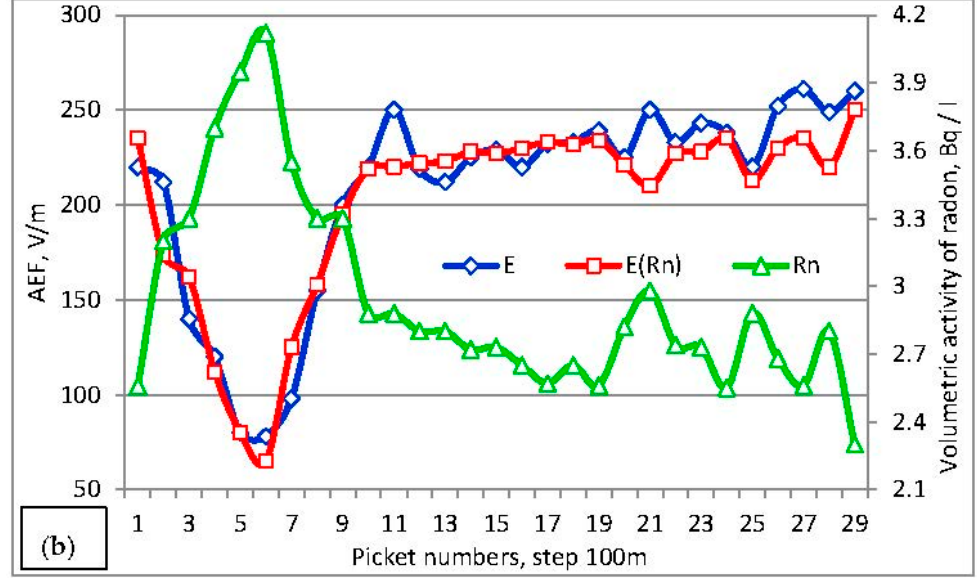
Figure 6. Variations of AEF—E(1989), E(1993) near the well on the 3rd Rechitsa oilfield ( a ); Variations of AEF—E, E(Rn) and volume activity of ground radon—Rn on the Aleksandrovskaya oil deposit (Belarus) ( b